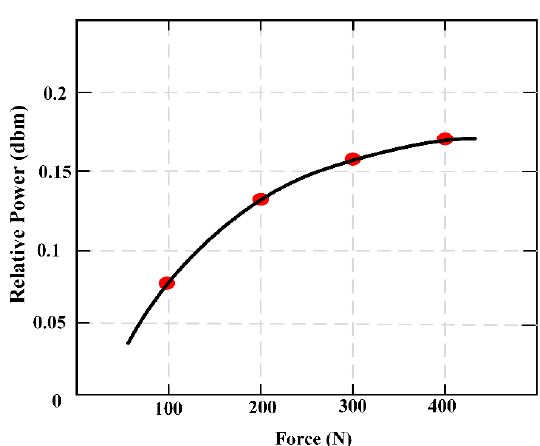
Figure 5. The external applied force (F) and relative powers (dbm).